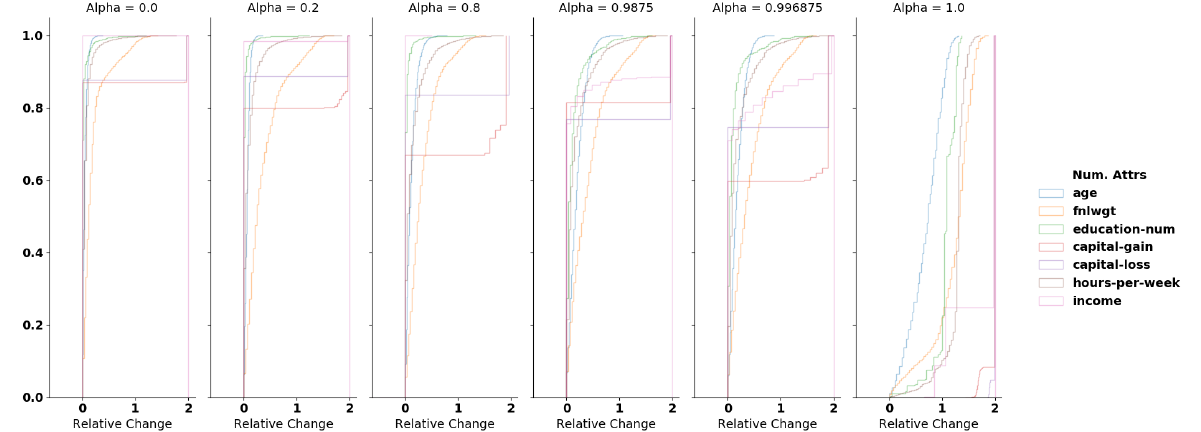
Figure A1. Cumulative distribution of the relative change (x-axis) for numerical attributes, versus the ratio of records affected in the dataset (y-axis).